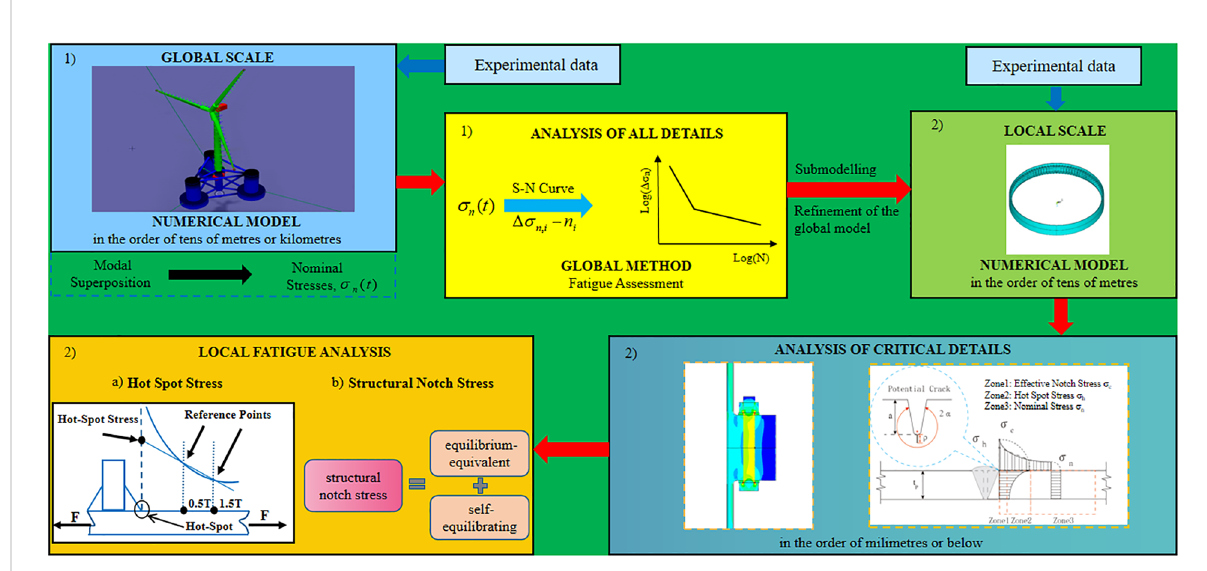
FIGURE 4 Work fl ow of the global-local fatigue assessment methodology for offshore wind